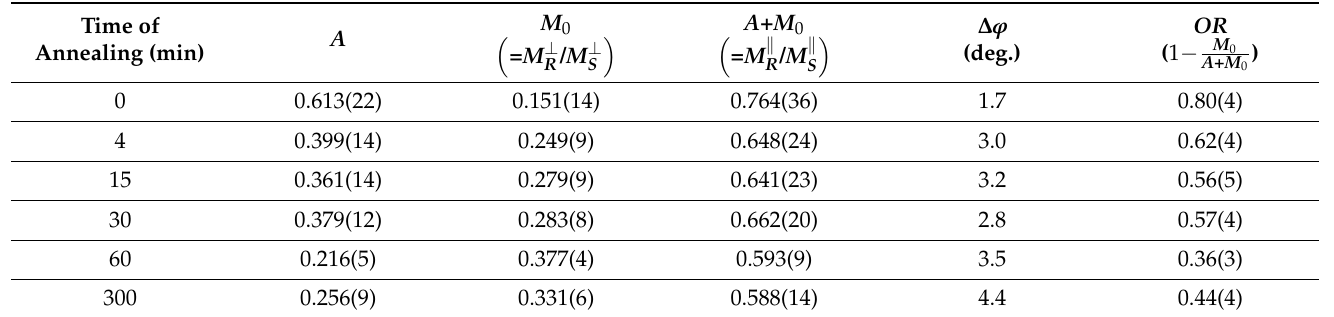
Table 2. Parameters of the M R / M S ( ϕ ) dependence fitted with Equation (2), together with the calculated orientation ratio